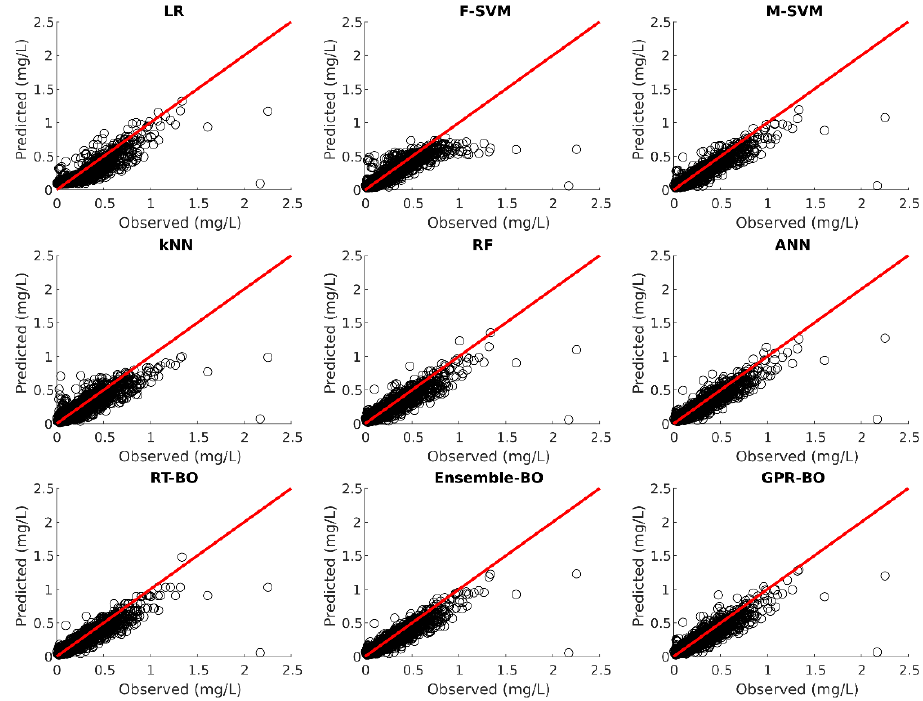
Figure 11. Observed versus predicted daily phosphorus concentration for Raisin using different ML.